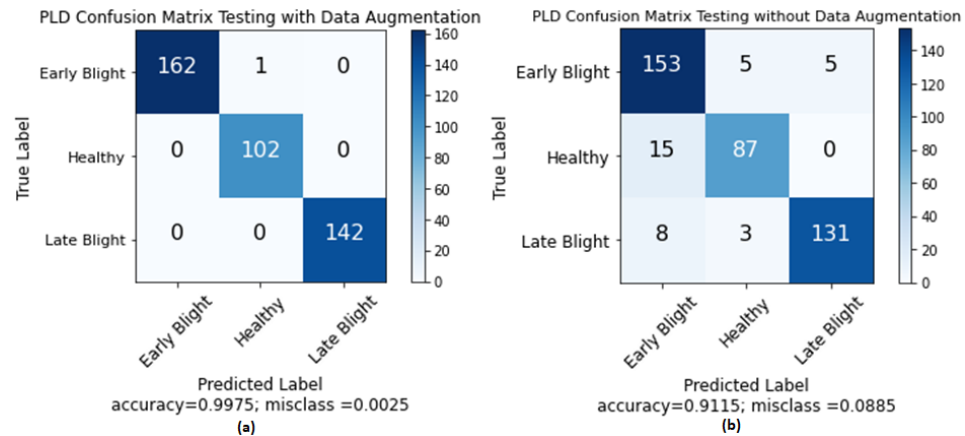
Figure 8. ( a ) PDDCNN precision, recall and F1-Score on the PLD dataset with data augmentation. ( b ) PDDCNN precision, recall and F1-Score on the PLD dataset without data augmentation.